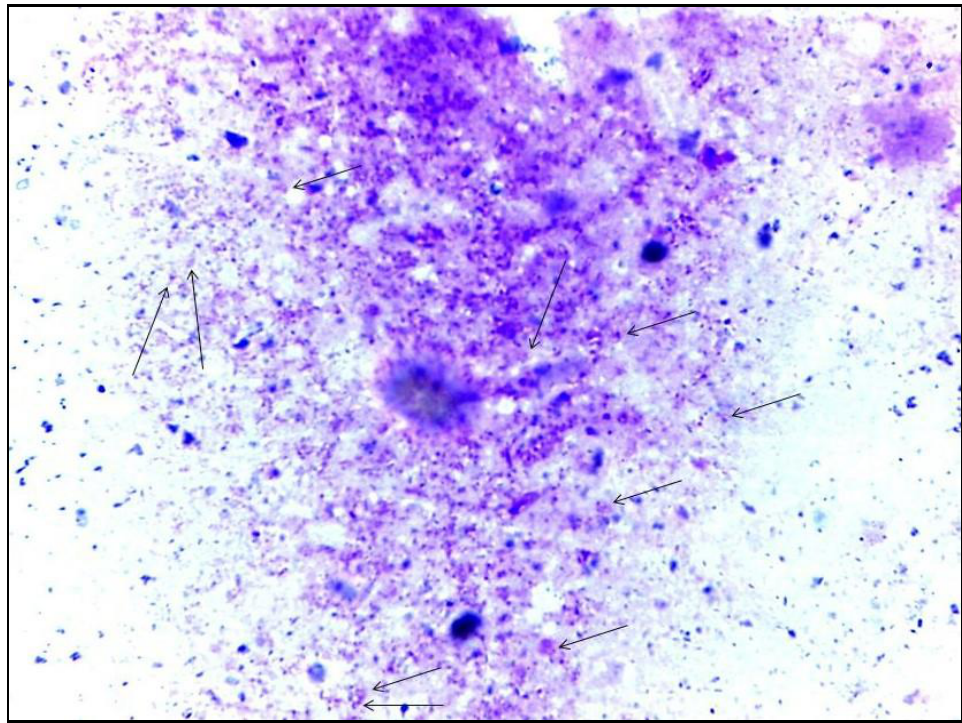
Figure 3. Leishmania amastigotes in Giemsa-stained smears from the ear of Jaculus species under oil immersion (×1000) (Leica DM50).